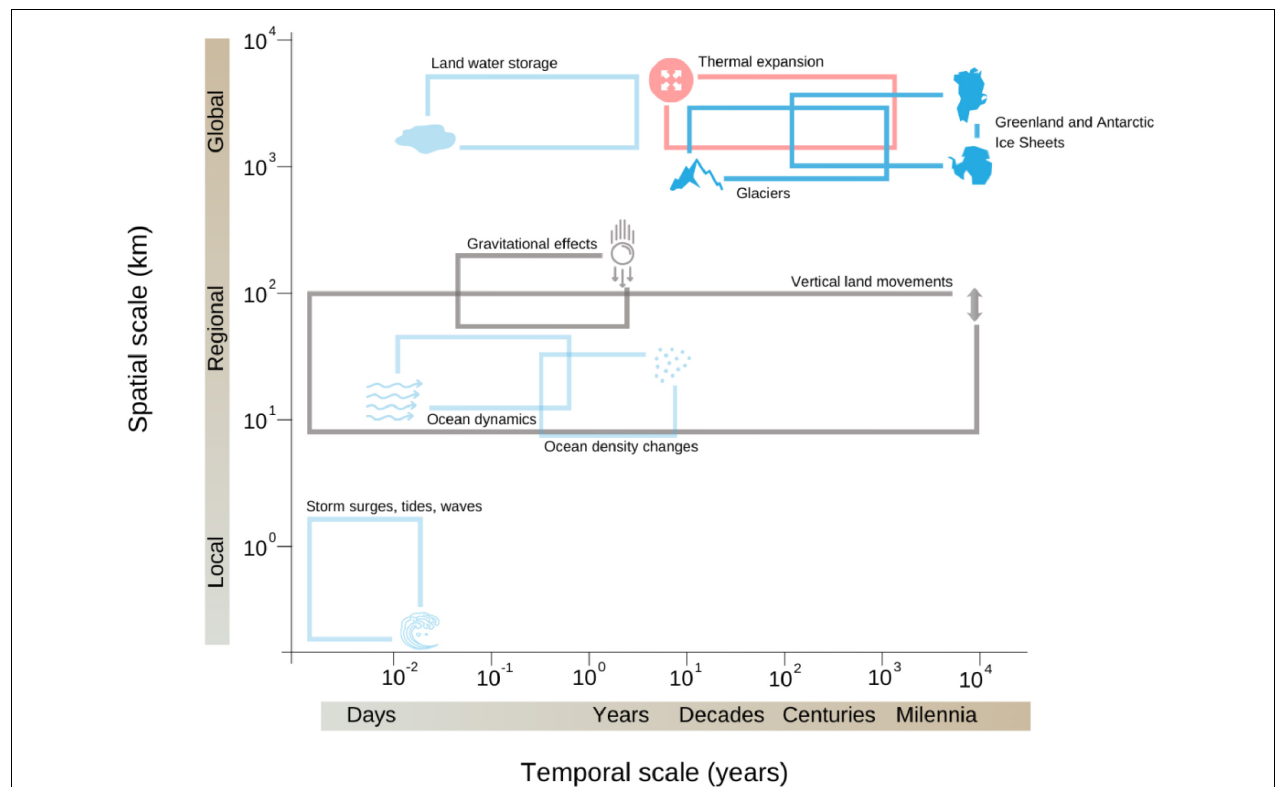
FIGURE 1 | Illustration of the processes that contribute to sea level change with respect to their temporal and spatial scales.